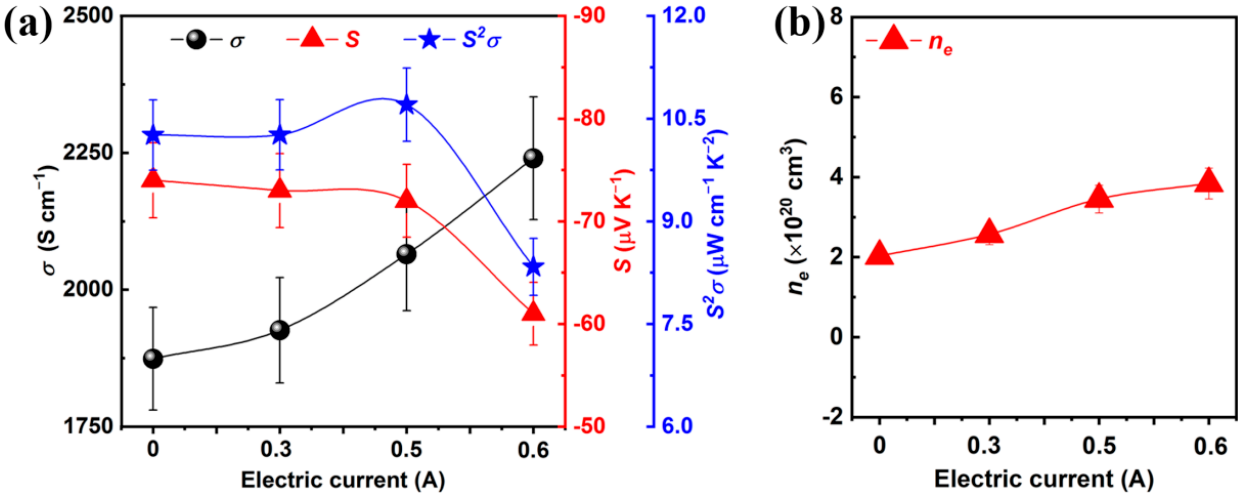
Figure 4. ( a ) The room temperature σ , S , and S 2 σ of Bi 2 Te 3 f-TF as a function of electric current. ( b ) Room temperature n e of Bi 2 Te 3 f-TF as a function of electric current.